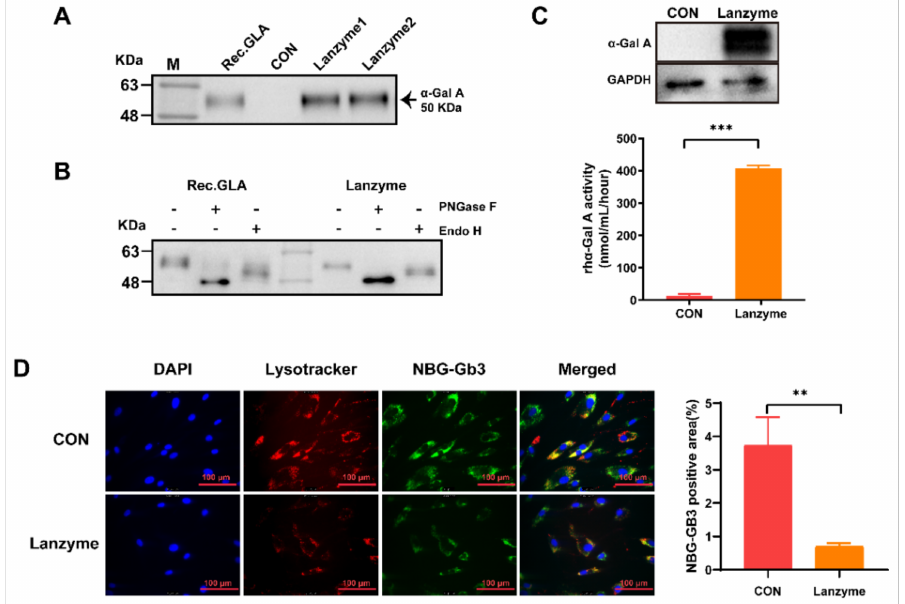
Figure 1. In vitro characterization studies of Lanzyme. ( A ) Lanzyme was expressed in CHO-S cells. M is the protein standard and molecular weights are shown on the left; Rec.hGLA produced in CHO cells is shown as a positive control; CON produced in CHO cells transduced with the pcDNA4 vector is shown as a negativecontrol; Lanzymes 1 and 2 were produced from different batches in CHO-S cells. ( B ) The glycosylation status of Lanzyme. Representative Western blotting image showing Rec.hGLA and Lanzyme, with and without PNGase F or Endo H digestion. ( C ) Internalization of Lanzyme in FD fibroblasts. FD fibroblasts were incubated with Lanzyme (0.5 nmol/L) for 5 h. α -Gal A protein levels and enzyme activity in cell lysates were measured by Western blot and α -galactosidase A ( α -Gal A) activity 2 days later. The data points α -Gal A enzyme activity shown are the three wells tested in parallel from one representative experiment. *** p < 0.001 compared to CON. ( D ) Internalization and lysosomal localization of Lanzyme in FD fibroblasts. FD fibroblasts were grown overnight on glass coverslips and incubated for 24 h in NBD-GB3 (10 µ g/mL), then incubated for 5 h in the presence or absence of Lanzyme (4 µ g/mL) and incubated for 24 h in a culture medium. DAPI (blue color) was used for staining the cellular nuclei. Note the colocalization of the lysosomal staining (red) and the NBG-Gb3containing granules (green). The overlap is represented in yellow when the images are superimposed. The data points shown are the three wells tested in parallel from one representative experiment. NBG-Gb3 semi-quantitative analyses were conducted using Image J software. ** p < 0.01 compared to